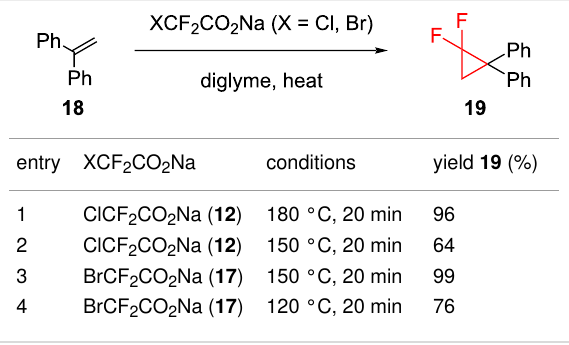
Table 1: Comparison of halodifluoroacetates 12 and 17 in the difluoro- cyclopropanation of 1,1-diphenylethene ( 18